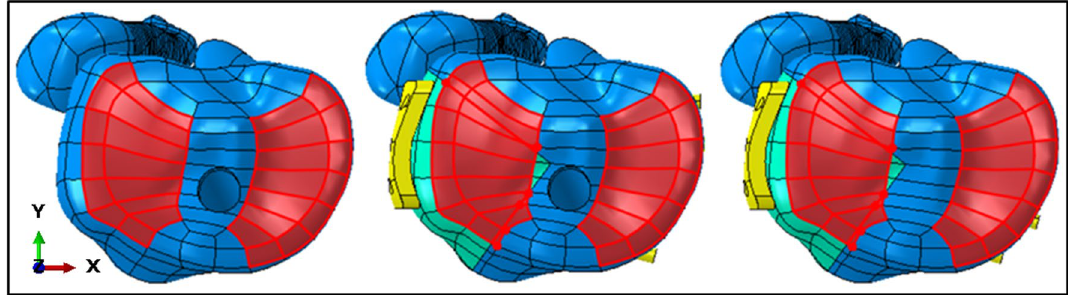
Figure 2. Load area of ITTT, fracture models with tibial tunnel and fracture models without tibial tunnel (take lateral column fracture as an example, created by Abaqus 6.14, https ://www.3ds.com/zh/produ cts-servi ces/simul ia/produ cts/abaqu